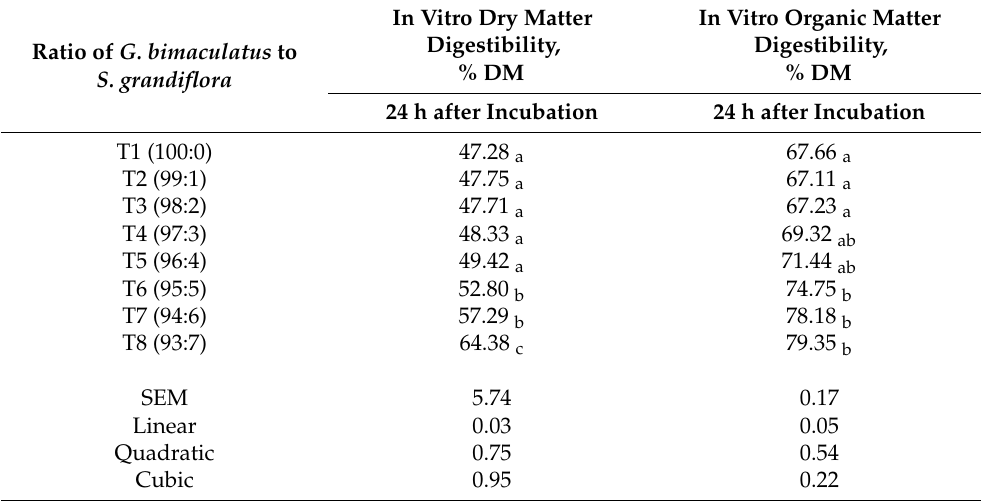
Ratio of G. bimaculatus